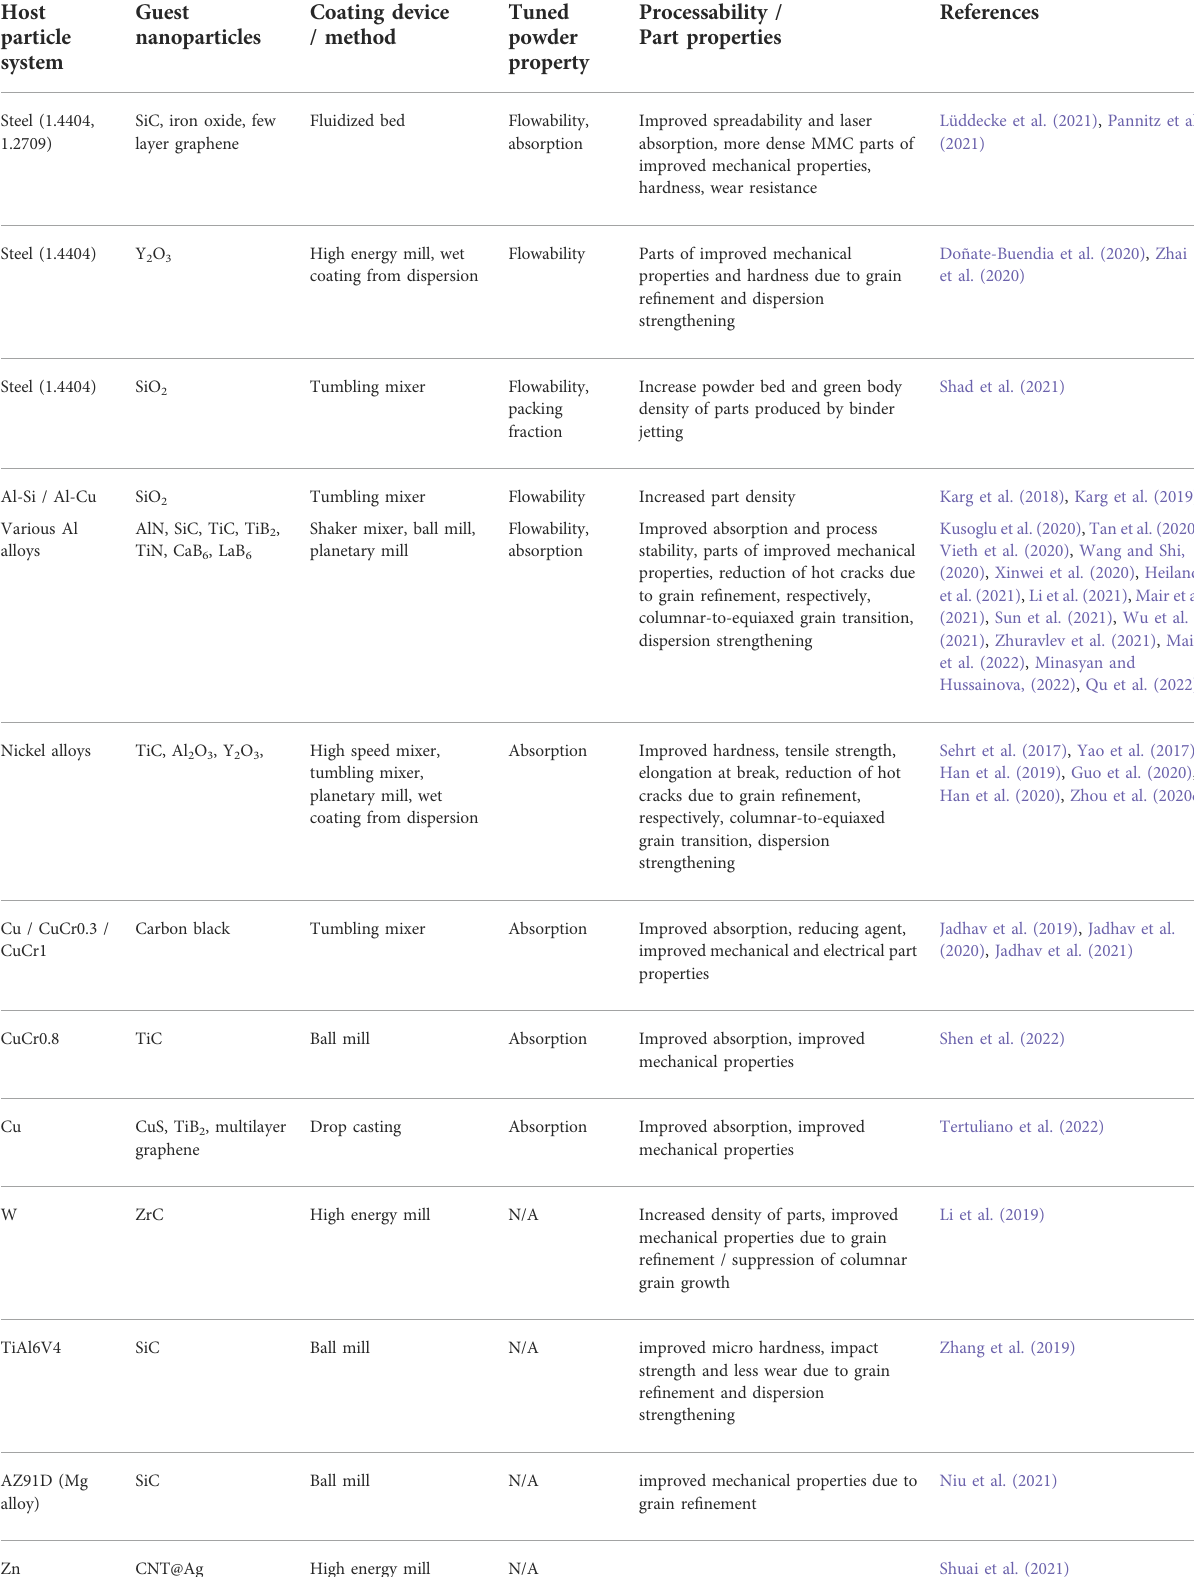
TABLE 2 Overview on (dry) coating of metal AM feedstocks for tailoring powder properties, respectively, processability and component